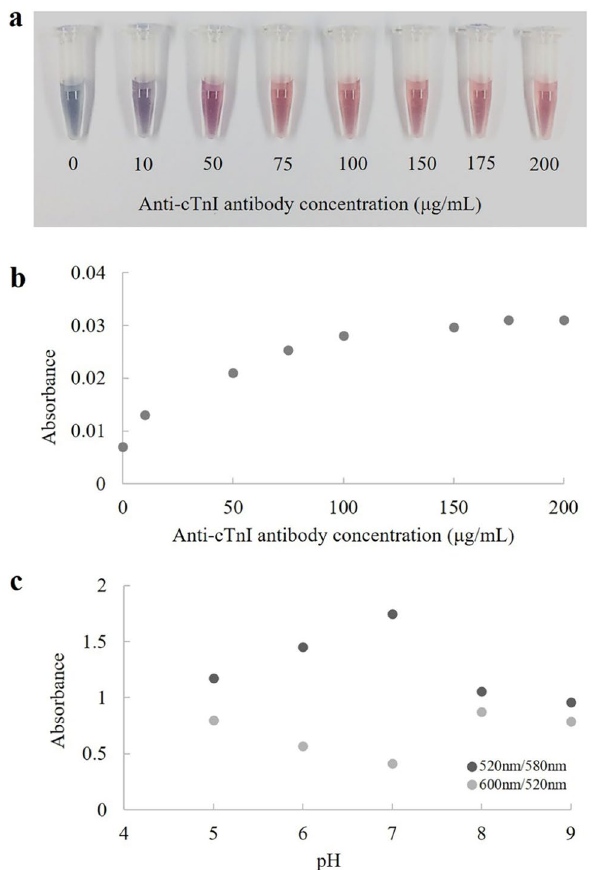
Figure 1. ( a ) The results of AuNP solutions with different concentrations of anti-cTnI antibody after adding 10% NaCl. ( b ) Plot of absorbance observed at 520 nm versus concentration of anti- cTnI antibody. ( c ) Plot of absorbance ratios of AuNPs across pH after adding of 10% NaCl with a fixed anti-cTnI antibody concentration of 175 µg/mL.